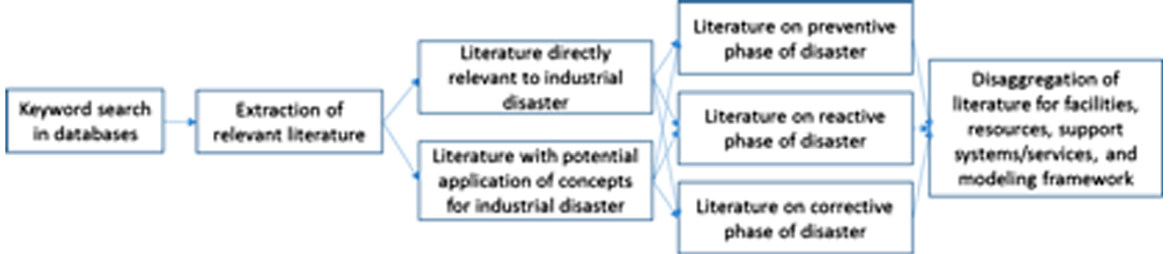
Figure 1. Methodology used for the literature review